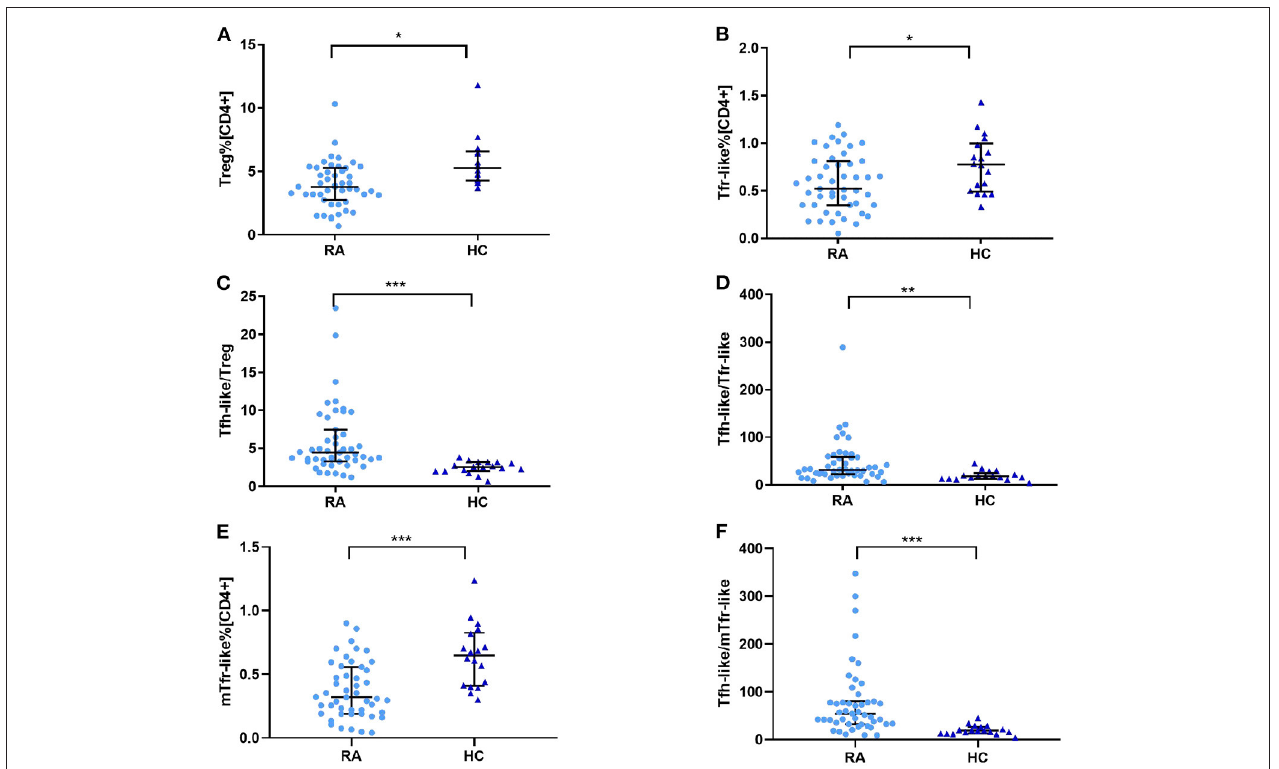
FIGURE 3 | (A) Treg cell percentage [CD4 + ], (B) Tfr-like cell percentage [CD4 + ], (E) mTfr-like cell percentage [CD4 + ], and (C) Tfh-like/Treg, (D) Tfh-like/Tfr-like, and (F) Tfh-like/mTfr-like cell ratios in the peripheral blood of RA patients and healthy controls. Data are shown as the median and interquartile range. The Mann–Whitney U test was used to compare the median values. * p < 0.05, ** p < 0.01, *** p < 0.001. Tfr-like, T follicular regulatory-like; mTfr-like, memory T follicular regulatory-like; Tfh-like, T follicular helper-like; Treg, T